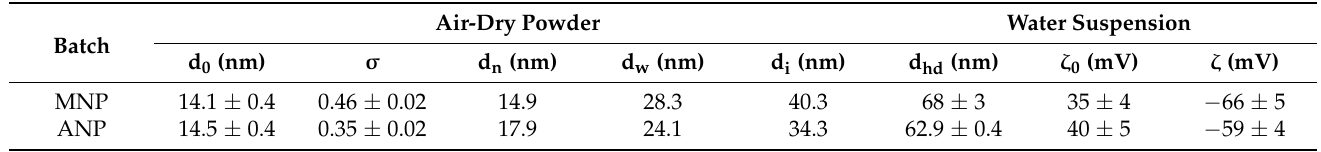
Table 1. Selected parameters of PSD for MNPs and ANPs in air-dry powder and water suspension.